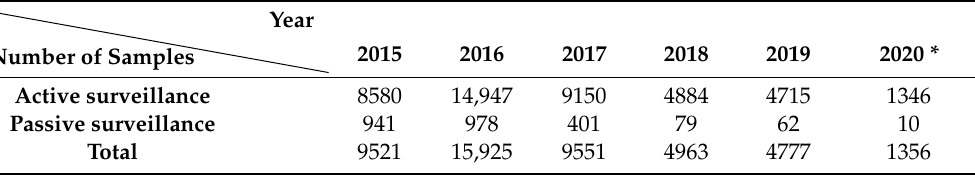
Table 1. Numbers of investigated wild boar samples for each year of the study period from active (i.e., from hunted animals) and from passive surveillance (i.e., from animals found dead, shot due to sickness or killed in road tra ffi c accidents)